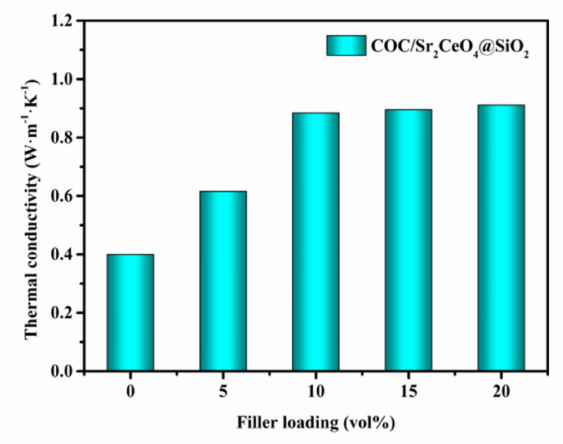
Figure 6. The in-plane thermal conductivity of COC/Sr 2 CeO 4 @SiO 2 composites. To verify the TC of the composites, the samples were characterized by infrared thermal imaging. The samples were cut into 2 cm × 2 cm squares in advance, and the temperature of the heating stage was kept at 80 ◦ C. The cut sample was quickly placed on the heating stage, and the heating process of the sample was recorded with a thermal imager. When the sample temperature rose to 80 ◦ C, the sample was quickly transferred to the normal- temperature desktop, and the temperature change during the cooling process was recorded again. Figure 7 shows the temperature change curve and thermal infrared image of the heating and cooling process. The introduction of filler leads to an increase in the heating and cooling rate of the samples. In summary, the filler Sr 2 CeO 4 @SiO 2 helps to improve the heat transfer capability of the